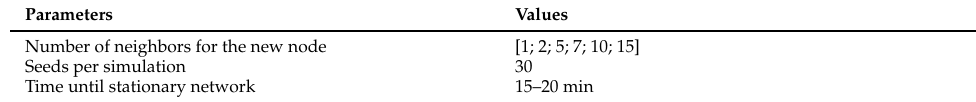
Table 3. Simulation configuration.